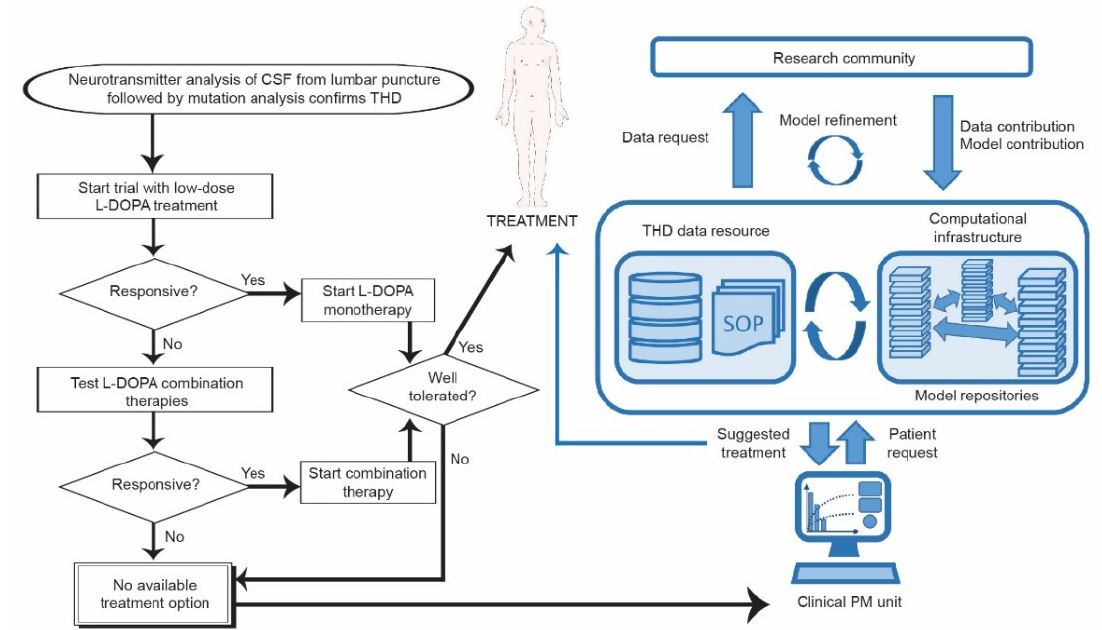
Figure 4. Towards personalized medicine approaches for THD. For both current and future treatment approaches the starting point is the diagnosis of THD from neurotransmitter analysis of CSF from lumbar puncture, followed by mutation analysis of the TH gene. The current mainstay treatment for THD is the administration of L-DOPA and carbidopa [2] (depicted as L-DOPA monotherapy in the figure). To date, some patients with unfavorable response to L-DOPA monotherapy have been given additional therapeutics, such as dopamine agonists or inhibitors of dopamine metabolism (see text for details). Biochemical and cellular assays have been used to study a number of TH mutations, and such assays are currently being used in research efforts to develop novel THD therapeutics. Such ongoing efforts may lead to PM approaches for THD (in blue). We expect that in the future, data from biochemical and cellular assays may be fed into computational modeling infrastructures to aid in the prediction and selection of the best available treatment and delivery options for individual THD patients. Abbreviations: CSF, cerebrospinal fluid; THD, tyrosine hydroxylase deficiency; L-DOPA, 3,4-dihydroxyphenylalanine; SOP, standard operating procedure; PM, personalized medicine.